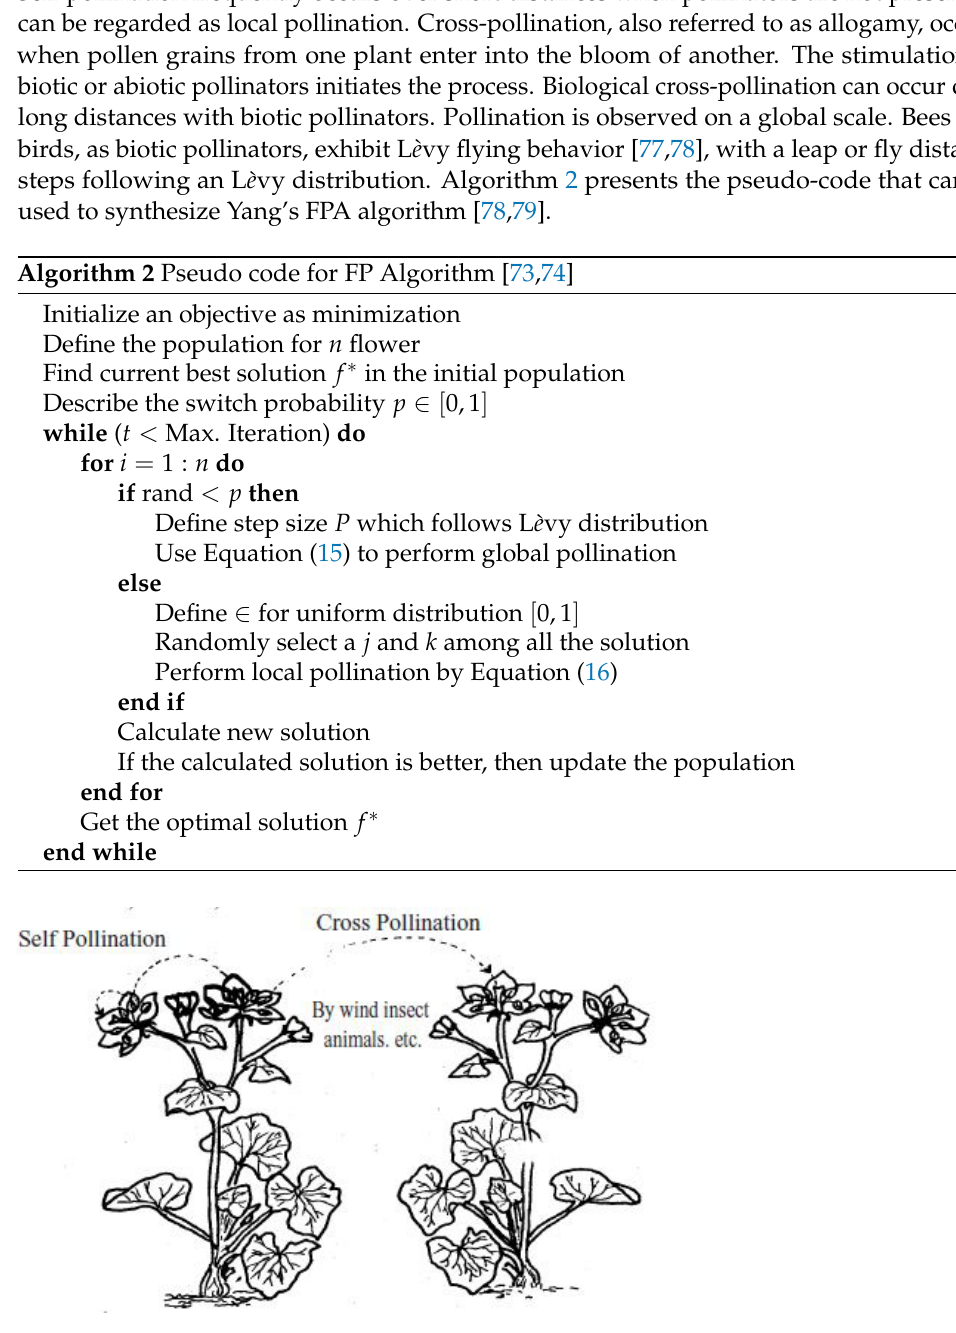
Figure 2. Flower pollination in nature